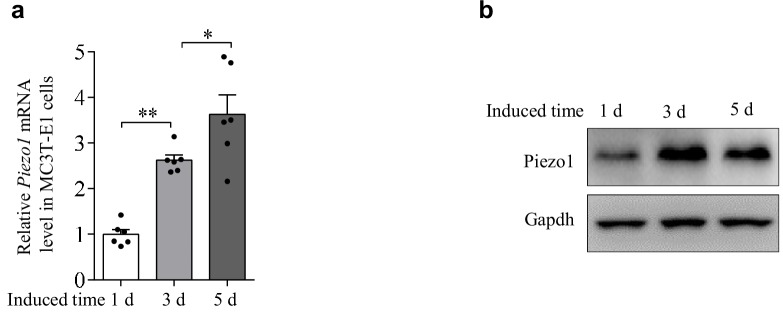
Osteogenic-induced expression of Piezo1 in the pre-osteoblast cell line MC3T3-E1.QRT-PCR analysis of Piezo1 mRNA level. (a) QRT-PCR analysis of Piezo1 mRNA level and (b) western blot analysis of Piezo1 protein level in the osteoblasts cultured with osteogenic medium for 1 day, 3 days and 5 days. All data are the mean ± s.e.m. from three independent experiments. *, p<0.05; **, p<0.01.